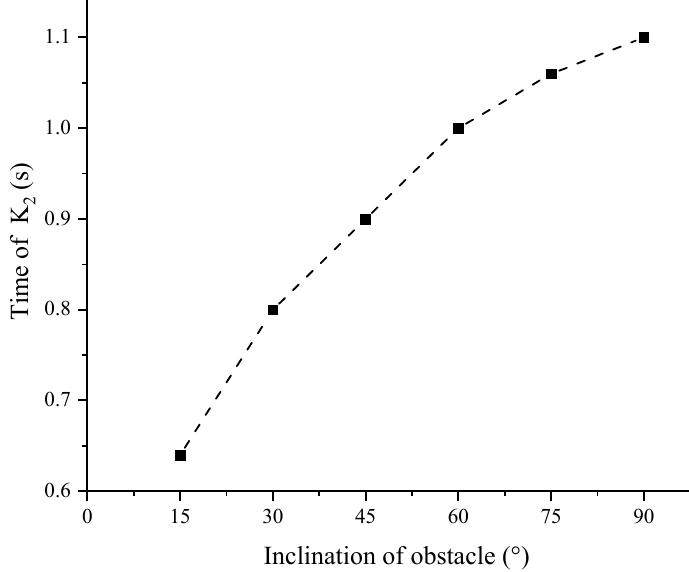
Figure 10. Arrival time of K 2 as a function of slope inclination angle α .